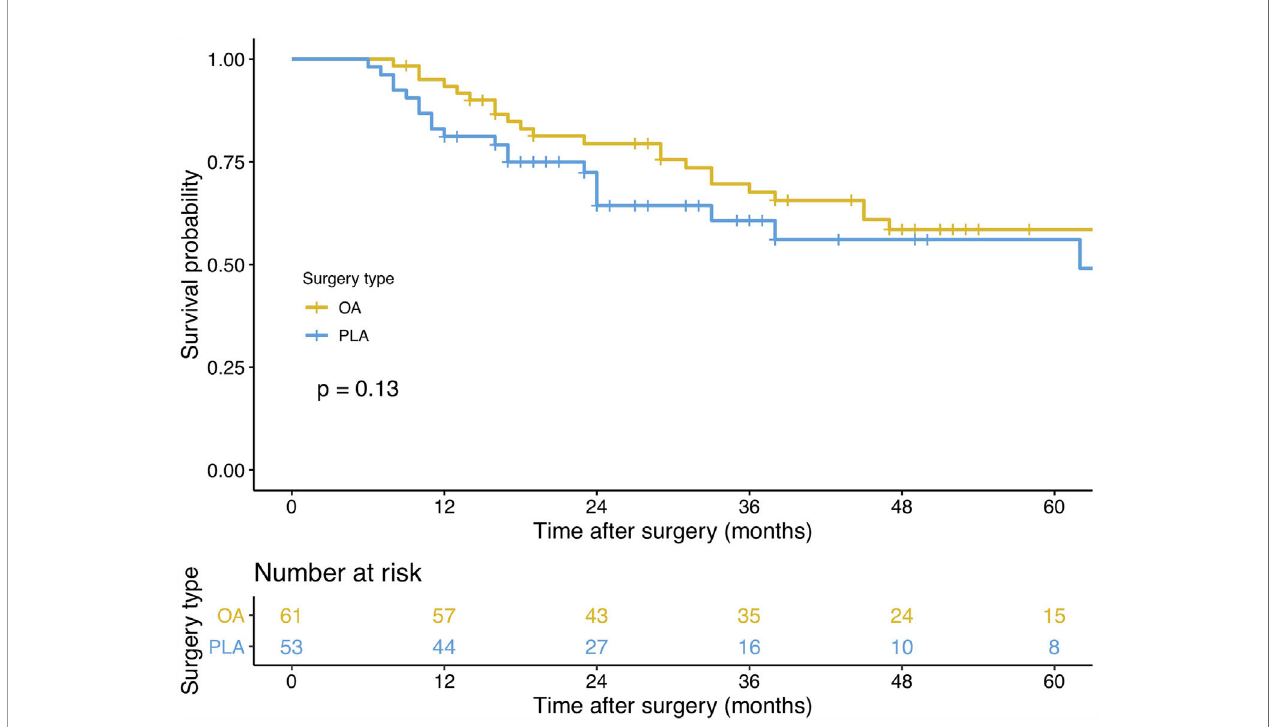
FIGURE 3 | A comparison of overall survival of primary outcomes after OA or PLA in GBC patients. OA, open approach; PLA, primary laparoscopic approach; GBC, gallbladder